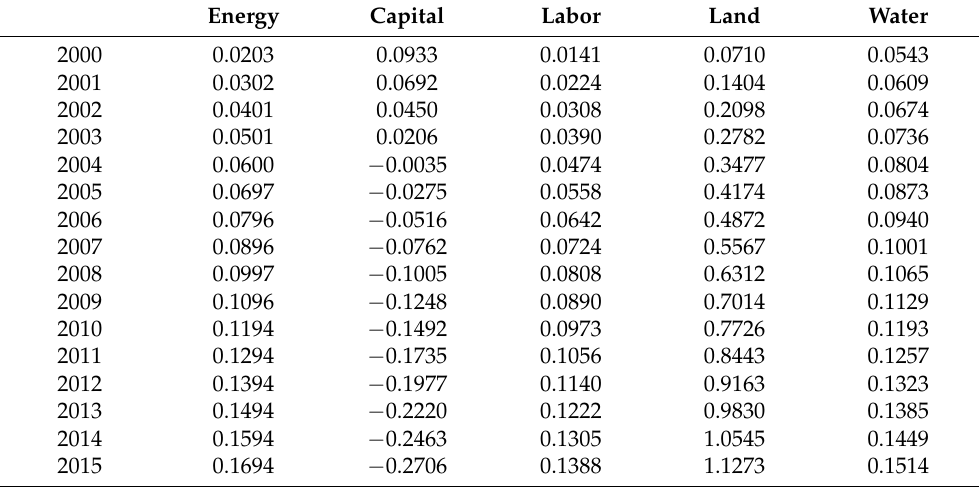
Table 5. Output elasticities of each input